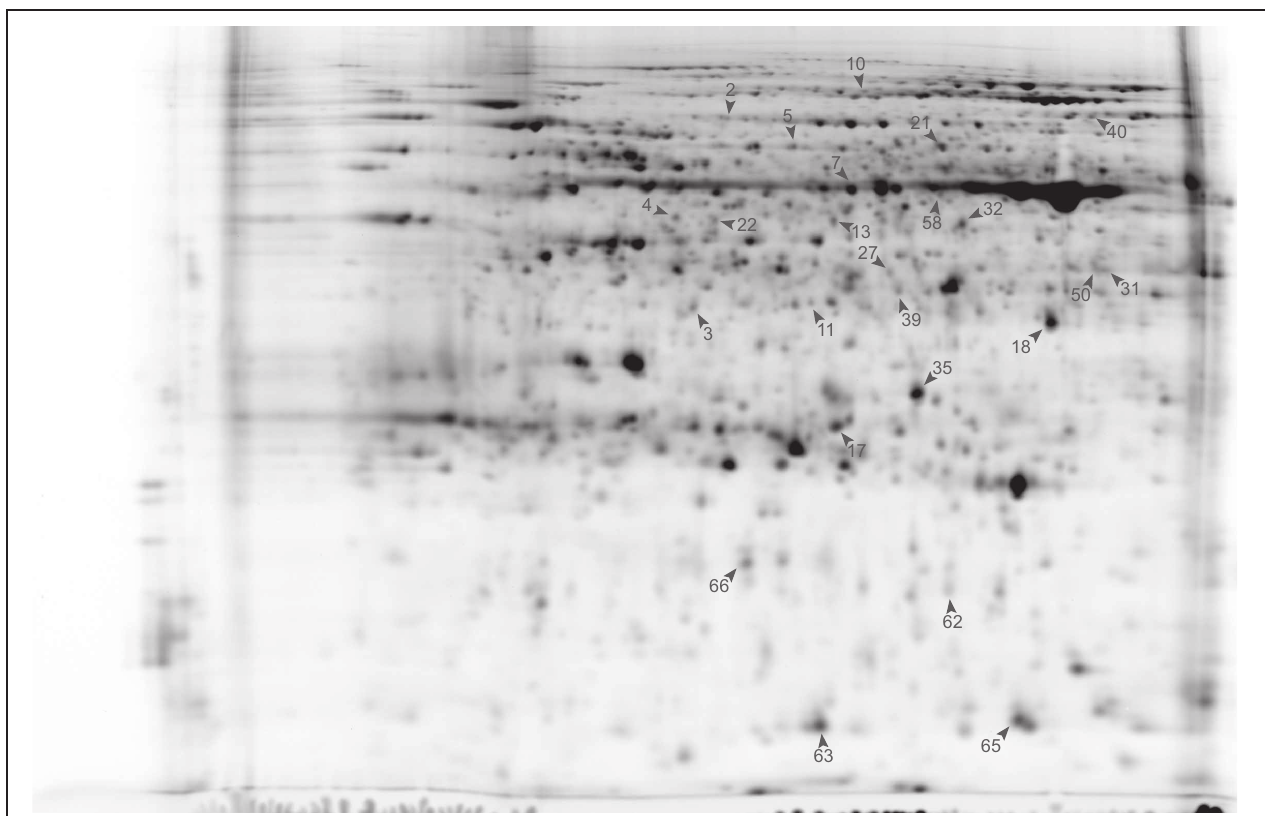
FIGURE 6 | Master gel Cy2 labeled (24cm pI 4–7). Identified proteins are numbered and indicated with an arrowhead (see Table 1